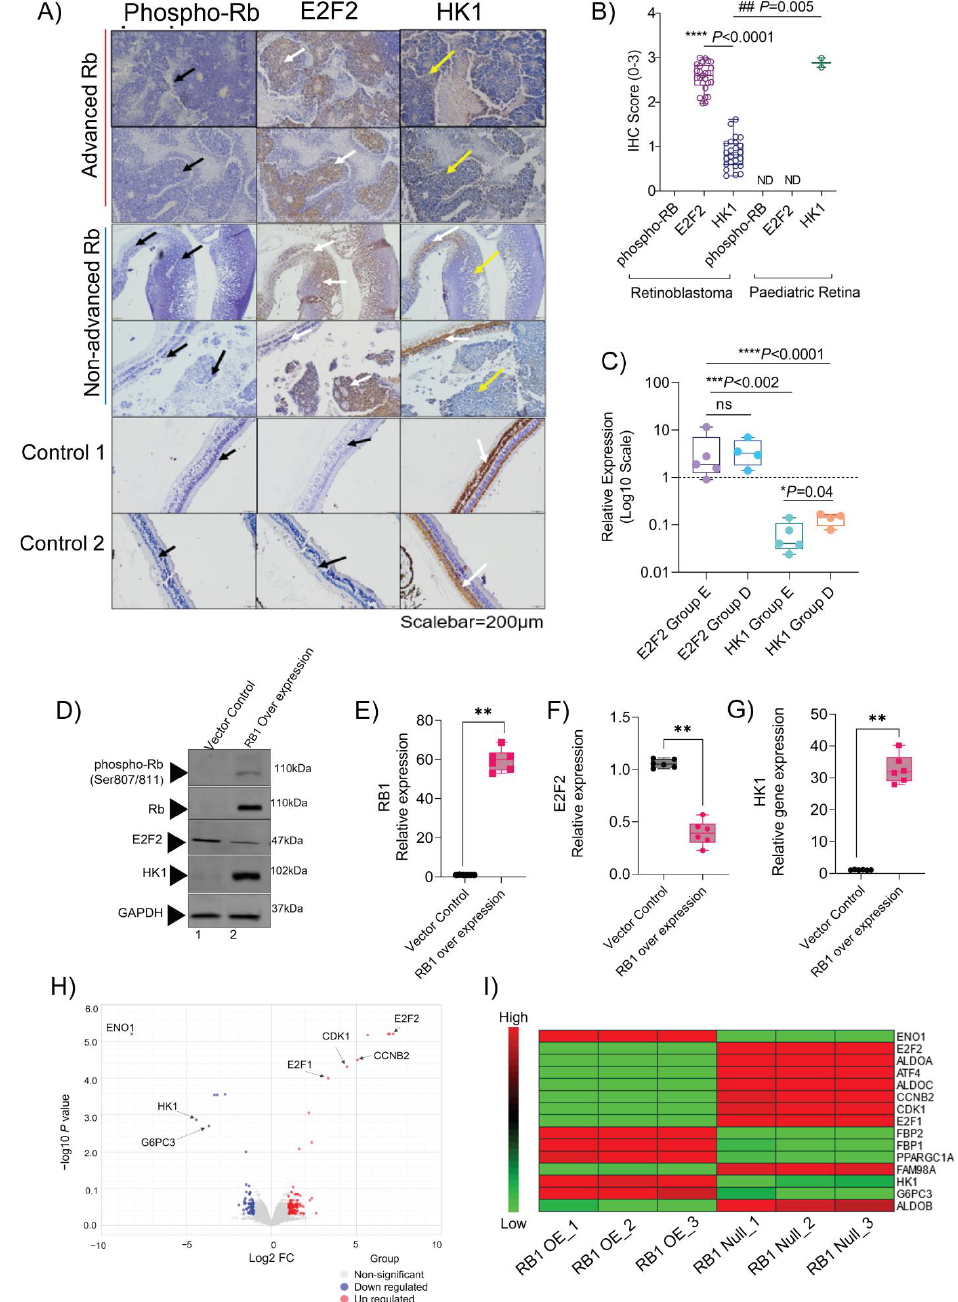
Figure 7. Differentially expressed targets confirm multi-omics findings in enucleated Rb tissue samples and in vitro. ( A ) Immunohistochemistry profile showing the expression of phospho-Rb, E2F2, and HK1 on 4 Rb tissues and 2 pediatric retinae. Scalebar = 200 µ m. ( B ) IHC scores of phospho-Rb, E2F2, and HK1 in 25 Rb tissues and 2 pediatric retina tissues. ( C ) Gene expression of E2F2 and HK1 in Rb subtypes relative to the pediatric retina. ( D ) Protein expression of phospho-Rb, Rb, E2F2, and HK1 in the control and RB1 -complemented WERI-Rb1 cells. Relative gene expression of ( E ) RB1 , ( F ) E2F2 , and ( G ) HK1 in control and RB1 -complemented WERI-Rb1 cells, which illustrate their differences at the molecular level. ( H ) Volcano plot of differentially regulated genes in RB1 -null and RB1 -complemented Y79 cells. ( I ) Heatmap showing significantly differentially expressed genes identified in the RB1 -null and RB1 - complemented Y79 cells. Values represent mean ± SEM. Unpaired two-sided Student’s t -test was used for statistical analysis. * p < 0.05, ** p < 0.01, *** p < 0.001, **** p < 0.0001, ## p =